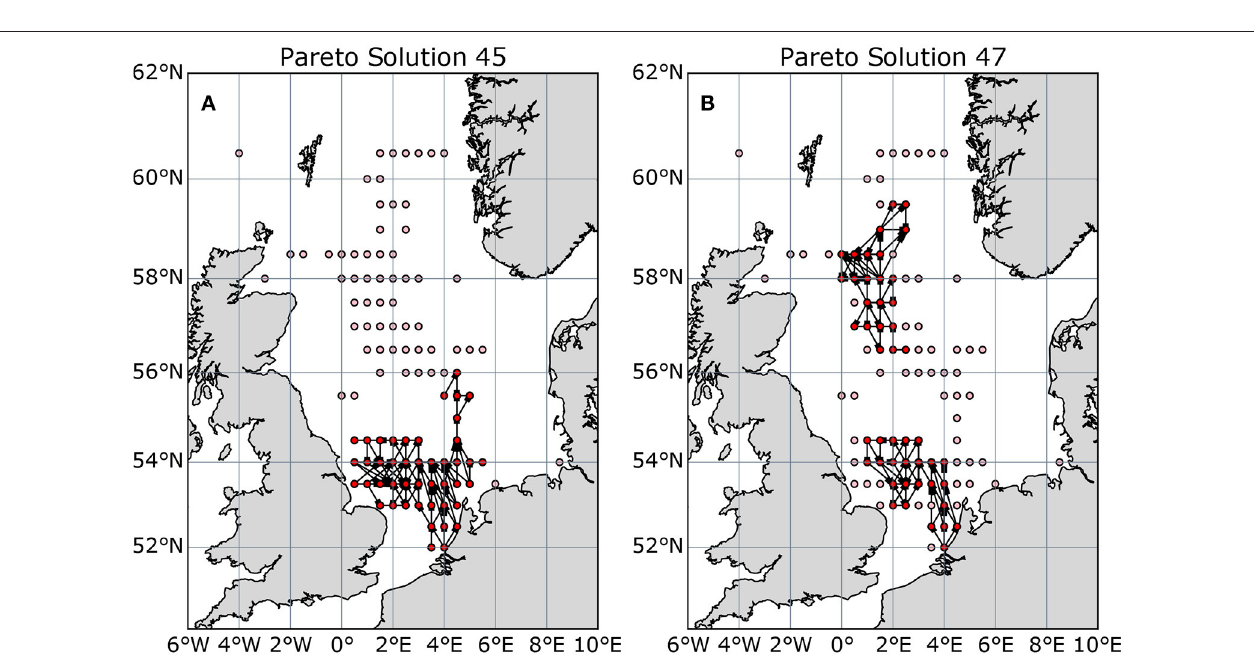
FIGURE 11 | Selected Pareto-optimal subnetworks of the North Sea gridded network, either side of the structural discontinuity at solution 45–47 (45–47 nodes protected) in Figure 10B . (A) optimal solution with 45 nodes protected; (B) 47 nodes protected. Bright red nodes are included in the subnetwork, light red are